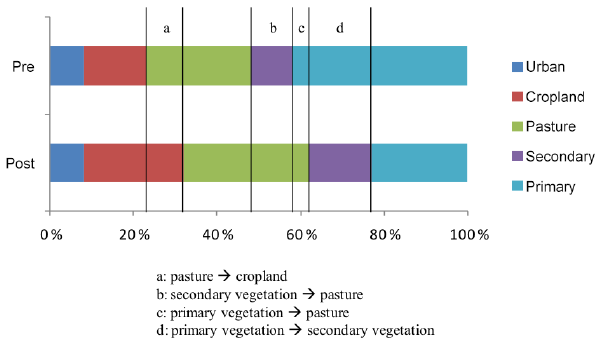
Figure B3. Schematic diagram of land-cover transition. Details are explained in the main